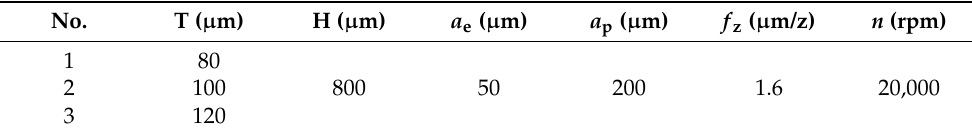
Table 3. Selection of simulation parameters.